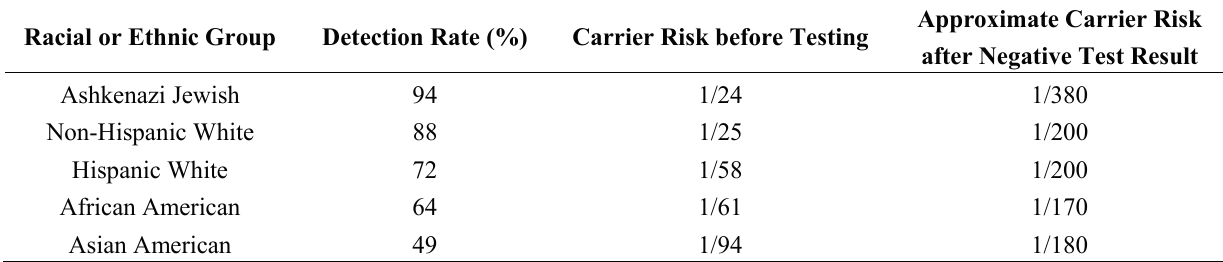
Table 2. Cystic fibrosis detection rates and carrier risk before and after testing [5]. Racial or Ethnic